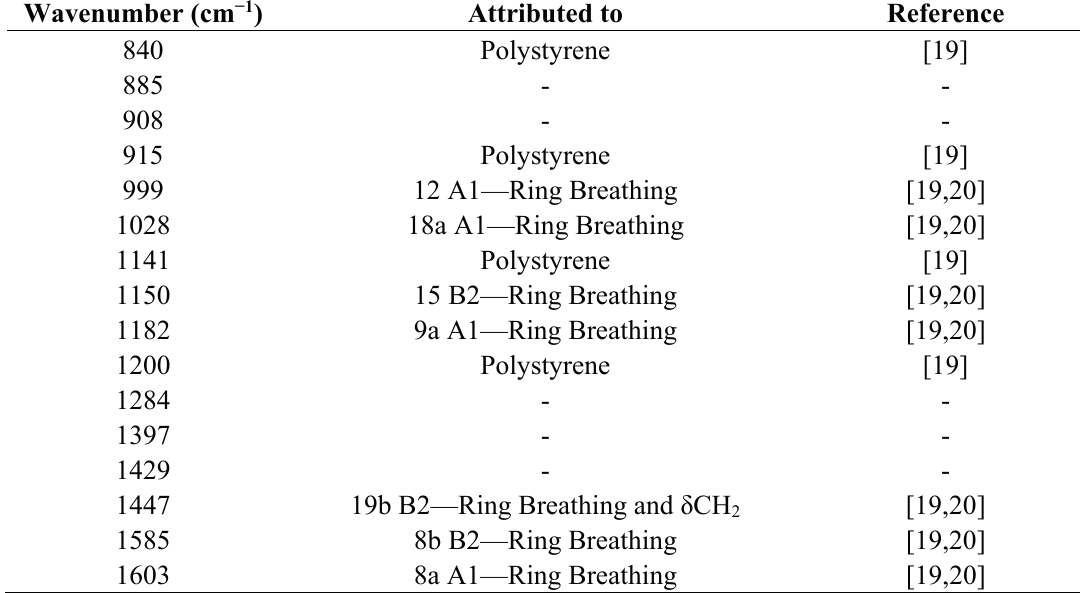
Figure 2. Micro-Raman Spectra of a cleaned silicon surface (black dashed line, left y -axis) and a dried, densely packed, photobleached layer NAVDY particles on a glass slide (red solid line, right y -axis). Table 1. Summary of identified peaks for NAVDY particles presented in Figure